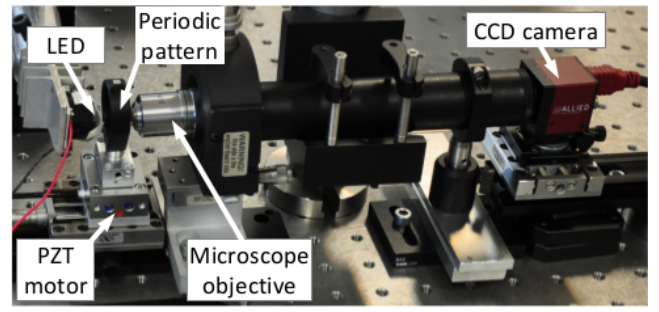
Figure 10. Experimental setup used for method